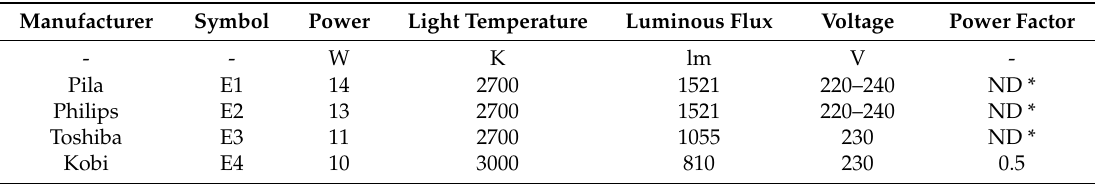
Table 1. Basic parameters declared by manufacturers of LED light sources.